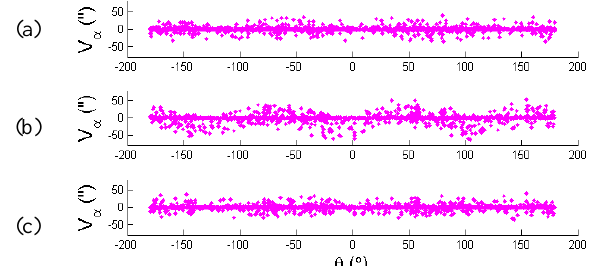
Figure 10: (a) Vertical angle residuals versus horizontal angle plot in plane-based self-calibration for hybrid scanners without systematic errors. (b) Unmodelled 3’ vertical circle index error. (c) After plane-based self-calibration.